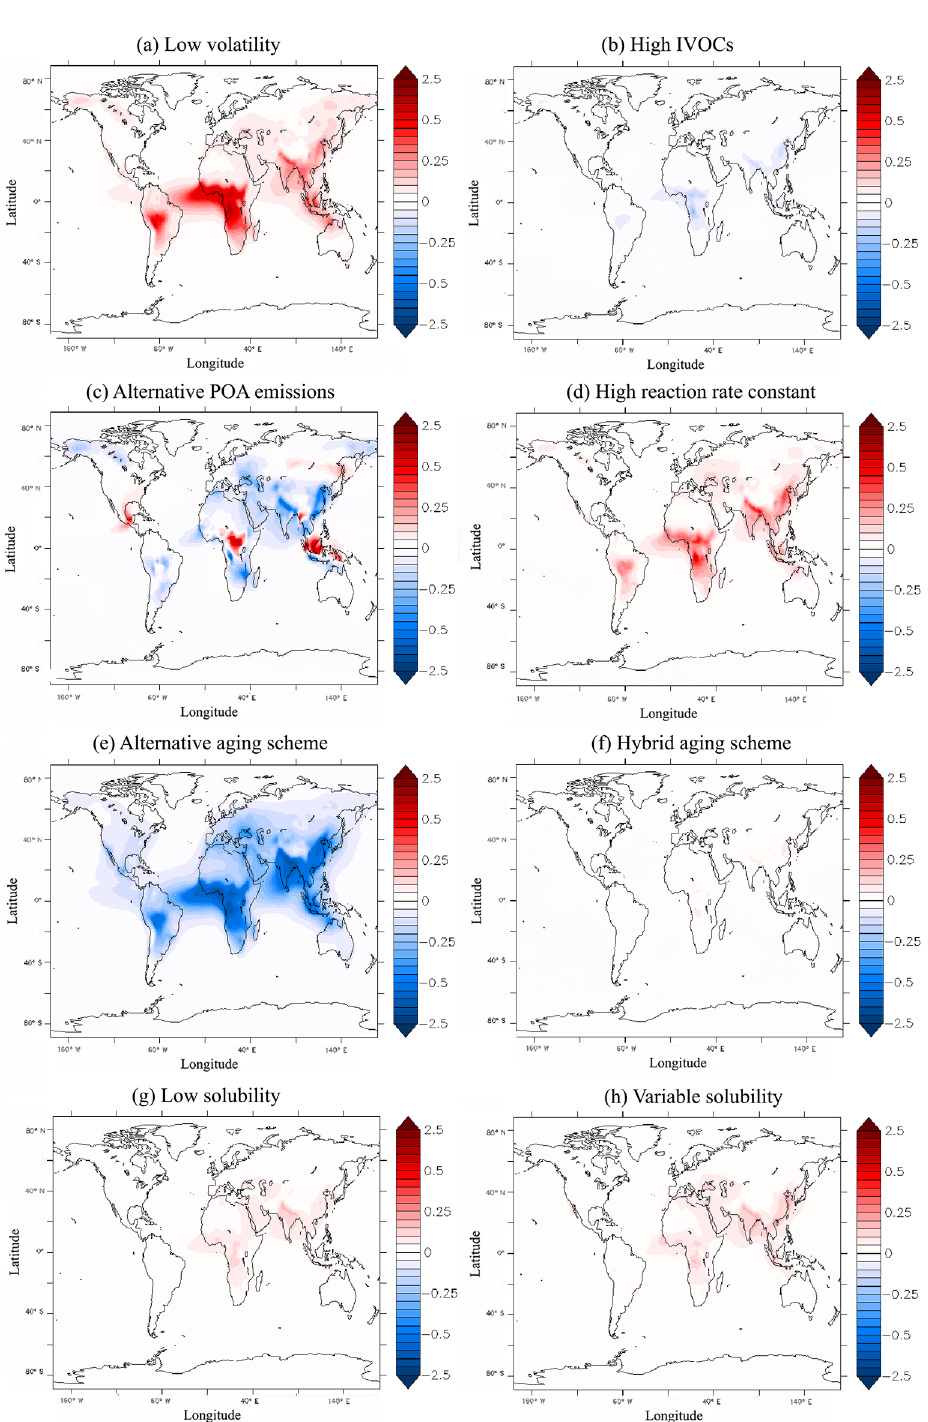
Figure 5. Absolute changes (inµgm − 3 ) of the average surface SOA concentrations from SVOCs (SOA-sv) between the reference and the (a) low-volatility, (b) high IVOCs, (c) alternative POA emissions, (d) high reaction rate constant, (e) alternative aging scheme, (f) hybrid aging scheme, (g) low-solubility, and (h) variable solubility simulations during the period 2001–2010. A positive change indicates an increase in the sensitivity